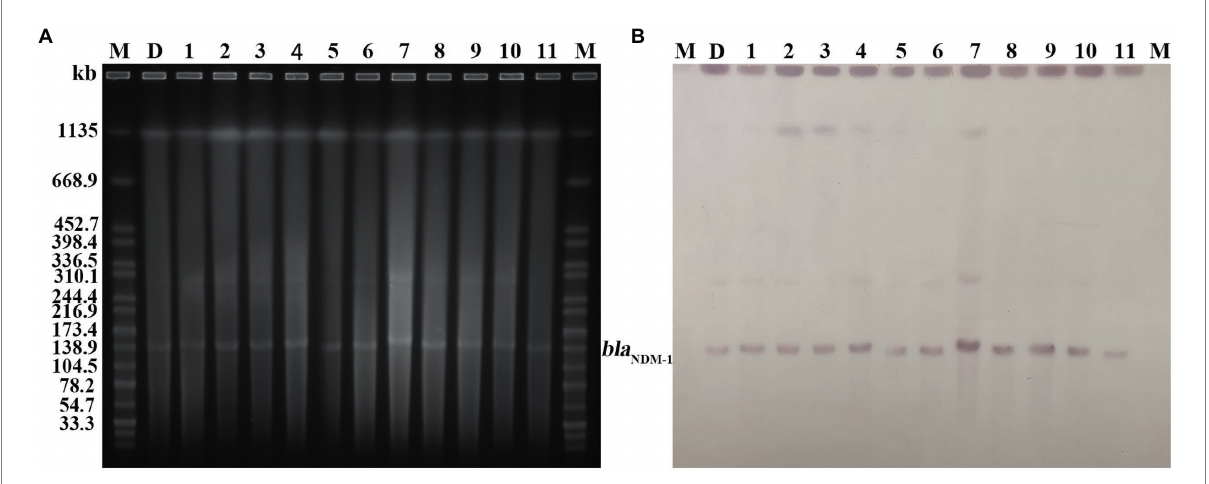
FIGURE 6 Plasmid profiles of the target strains. Letters and numbers indicate the same contents as in Figure 5. (A) Plasmid size determination by S1-PFGE. The bright bands at the top of each lane are the chromosomes of each strain, and the bright bands below are the plasmids. (B) Southern blot hybridization with plasmids using a bla NDM probe. The position of the blots indicates the position of the plasmids.